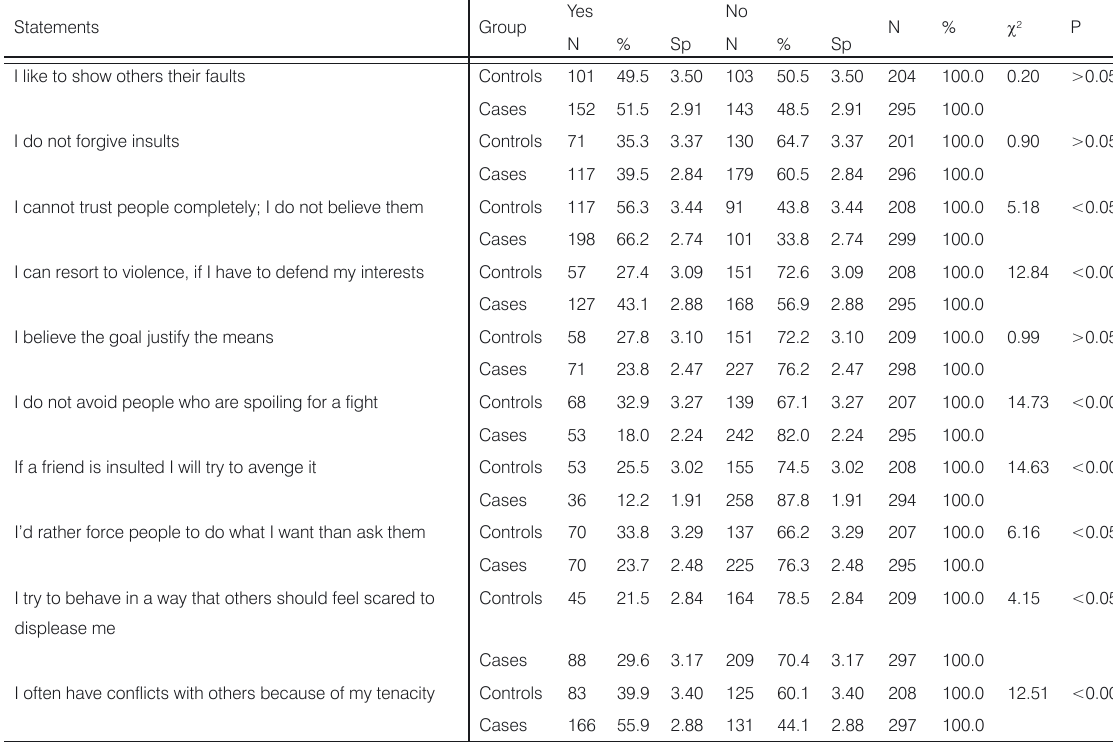
Table 1. Correlation between displayed aggression characteristics and